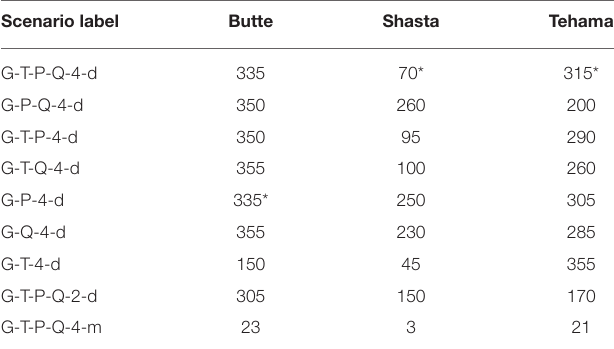
TABLE 4 | Optimal lag hyperparameter chosen in the hyperparameter optimization process at all three sites and for each scenario. Scenario label